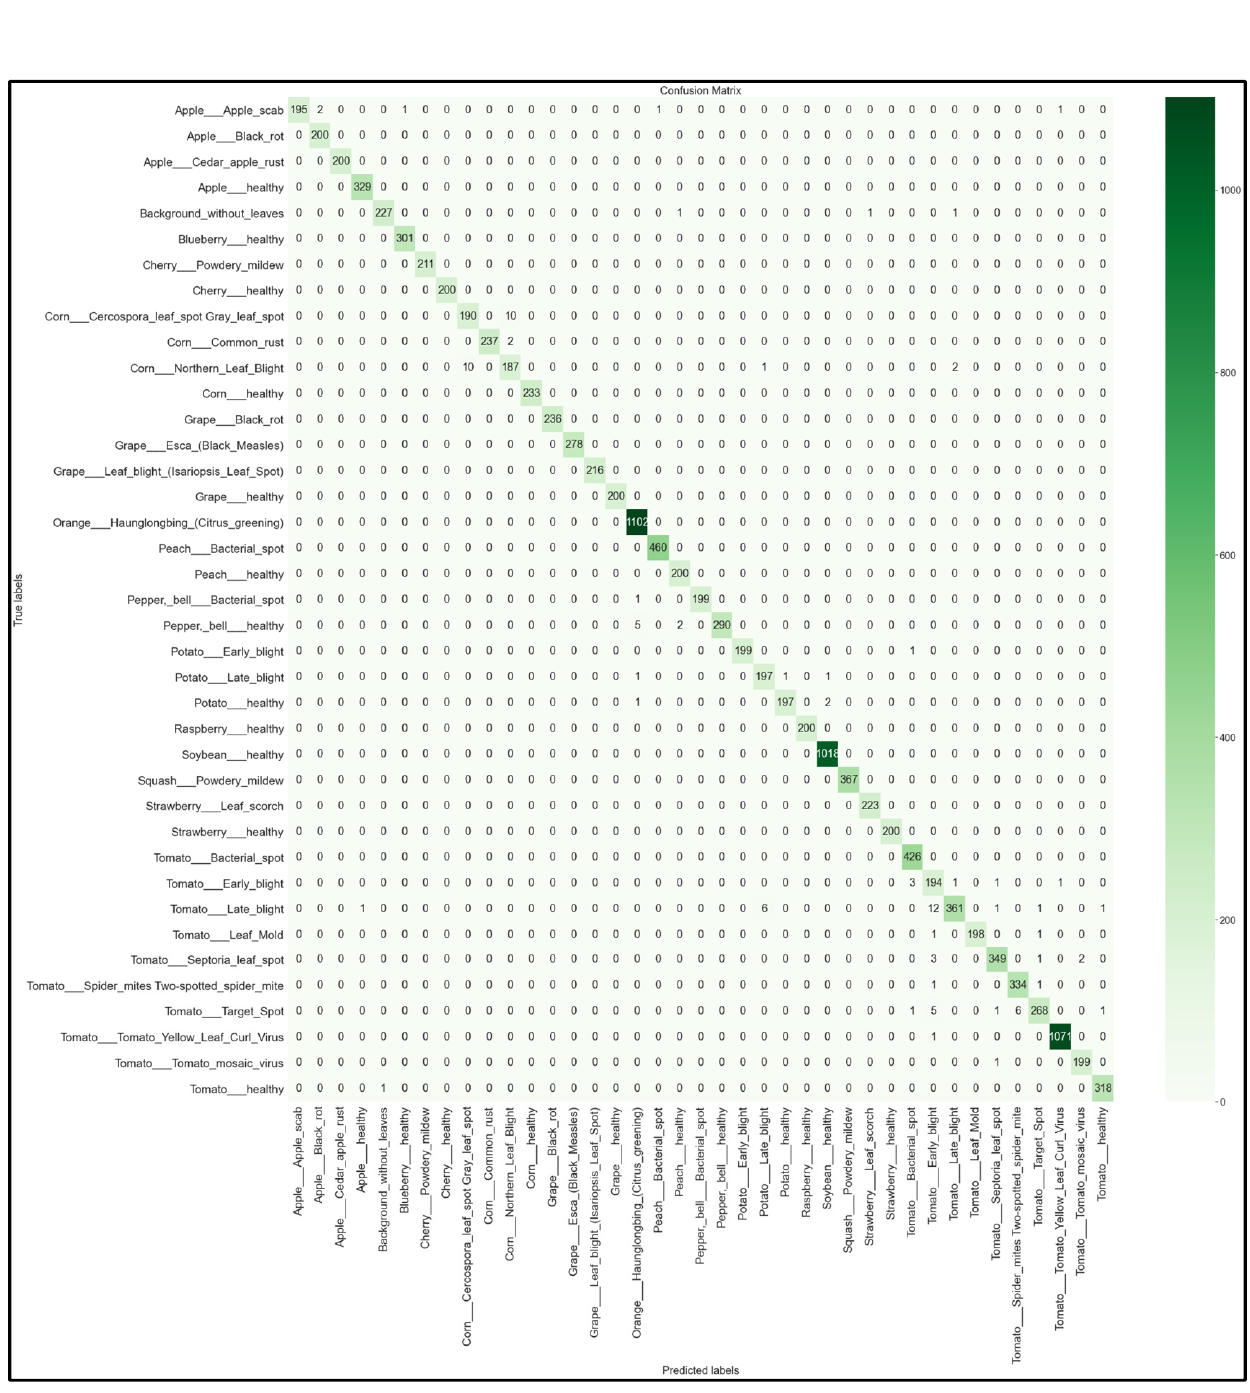
Figure 18. 39 × 39 Confusion matrix for the MobileNet model with transfer learning Scenario 4 and the Proposed hyperparameters.